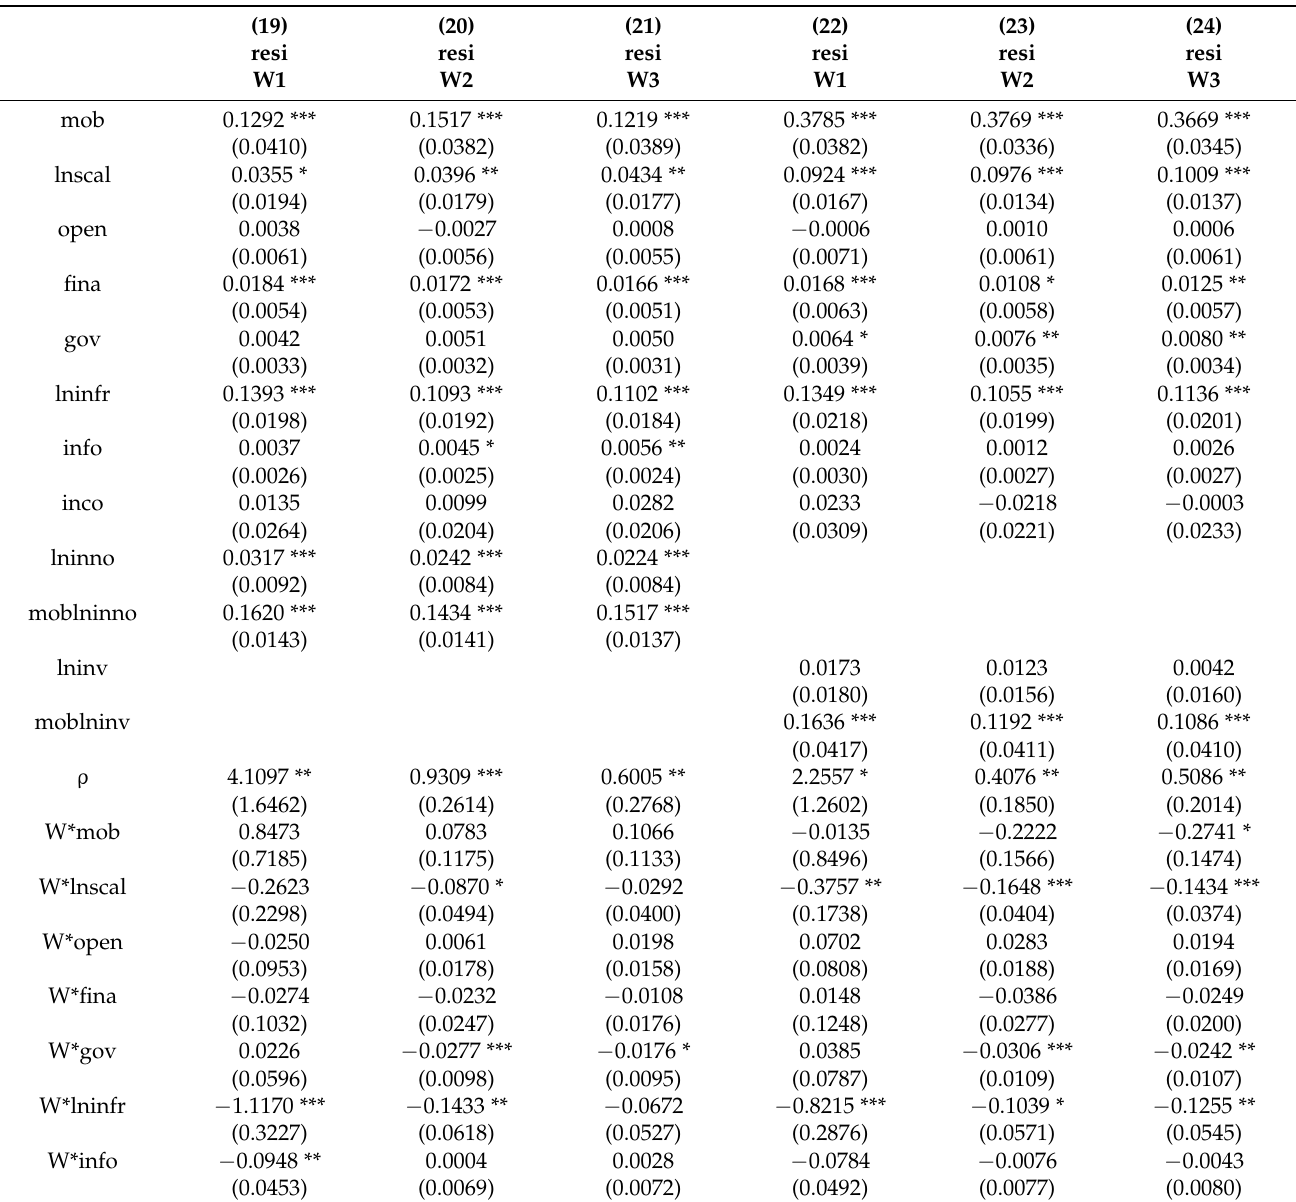
Table 8. The existence test results of innovation input and fixed asset investment